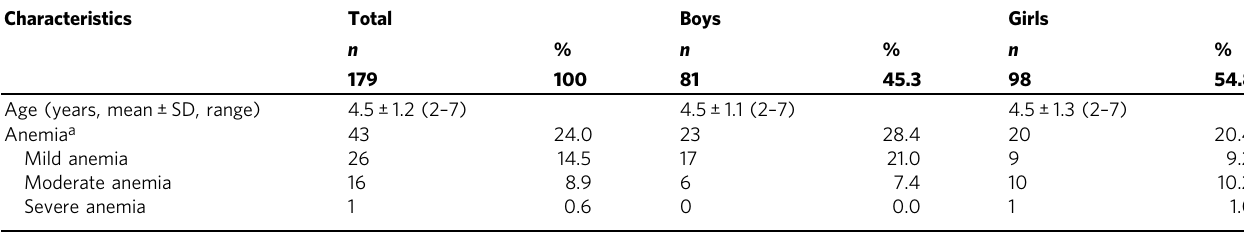
Table 2 Children ’ s characteristics including age and anemia prevalence in the pre-school sample.